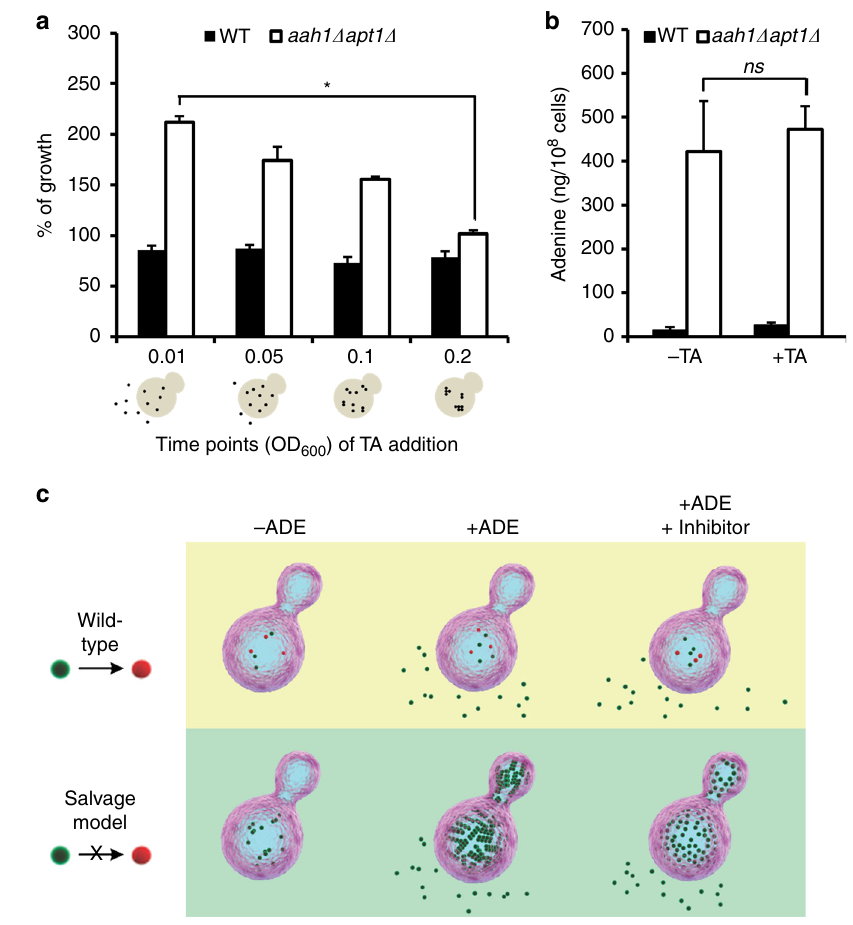
Fig. 5 TA rescues salvage model yeast by preventing adenine assembly into toxic amyloid-like structures. a WT and aah1 Δ apt1 Δ cells diluted to OD 600 0.01 were grown in SD media in the presence of adenine. 0.5 mM TA was added to the samples at different OD 600 values (0.01, 0.05, 0.1, and 0.2). * P < 0.01 (Student ’ s t -test). The percentage of growth represents the growth with TA compared to the growth without TA. Values are the mean ± s.d. of three experiments. Schematic illustrations of adenine assembly inside the cells at the different OD 600 values following the addition of TA are shown below the X - axis. b Intracellular concentration of adenine determined using GC – MS. WT and aah1 Δ apt1 Δ cells were grown in SD media in the presence of adenine, with or without 0.5 mM TA, and the metabolites were extracted. ns, not signi fi cant (Student ’ s t -test). Values are the mean ± s.d. of three experiments. c Schematic model of adenine accumulation in WT cells compared to the adenine salvage model in the absence or presence of adenine, and following the addition of the TA inhibitor. The model re fl ects the relative amounts of the metabolite as determined experimentally. Upon feeding of the salvage mutant with adenine, the metabolite accumulates into ordered assemblies. Administration of the inhibitor, as recently shown by an in vitro study 15 , prevents the formation of assemblies at the nucleation phase, without any signi fi cant effect on the total concentration of the